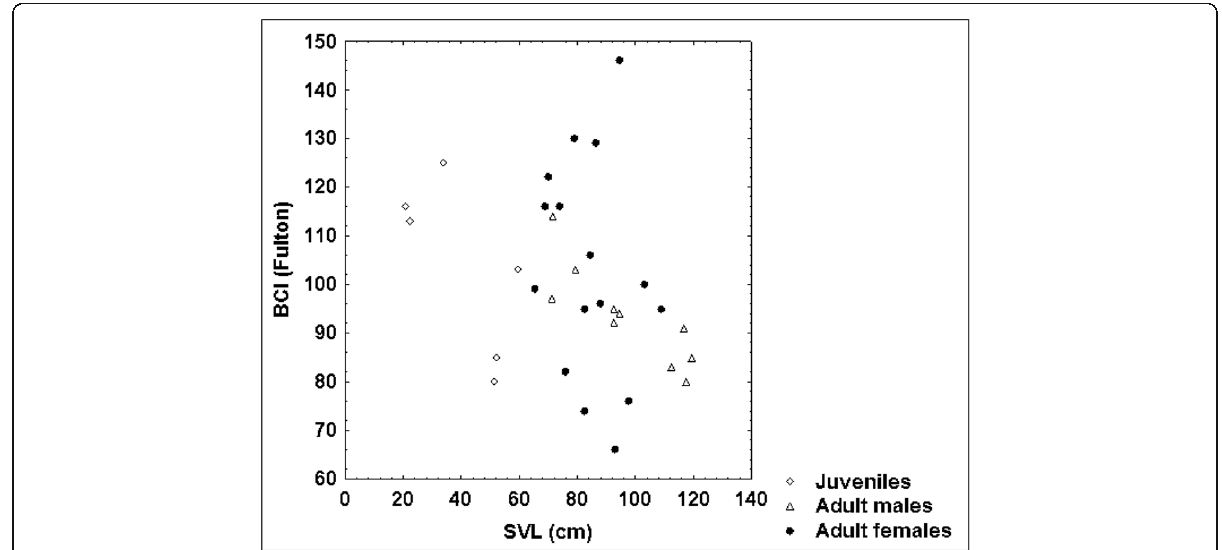
Fig. 8 Relationship between SVL and body condition index (BCI) in 34 blunt-nosed vipers from Cyprus: R =